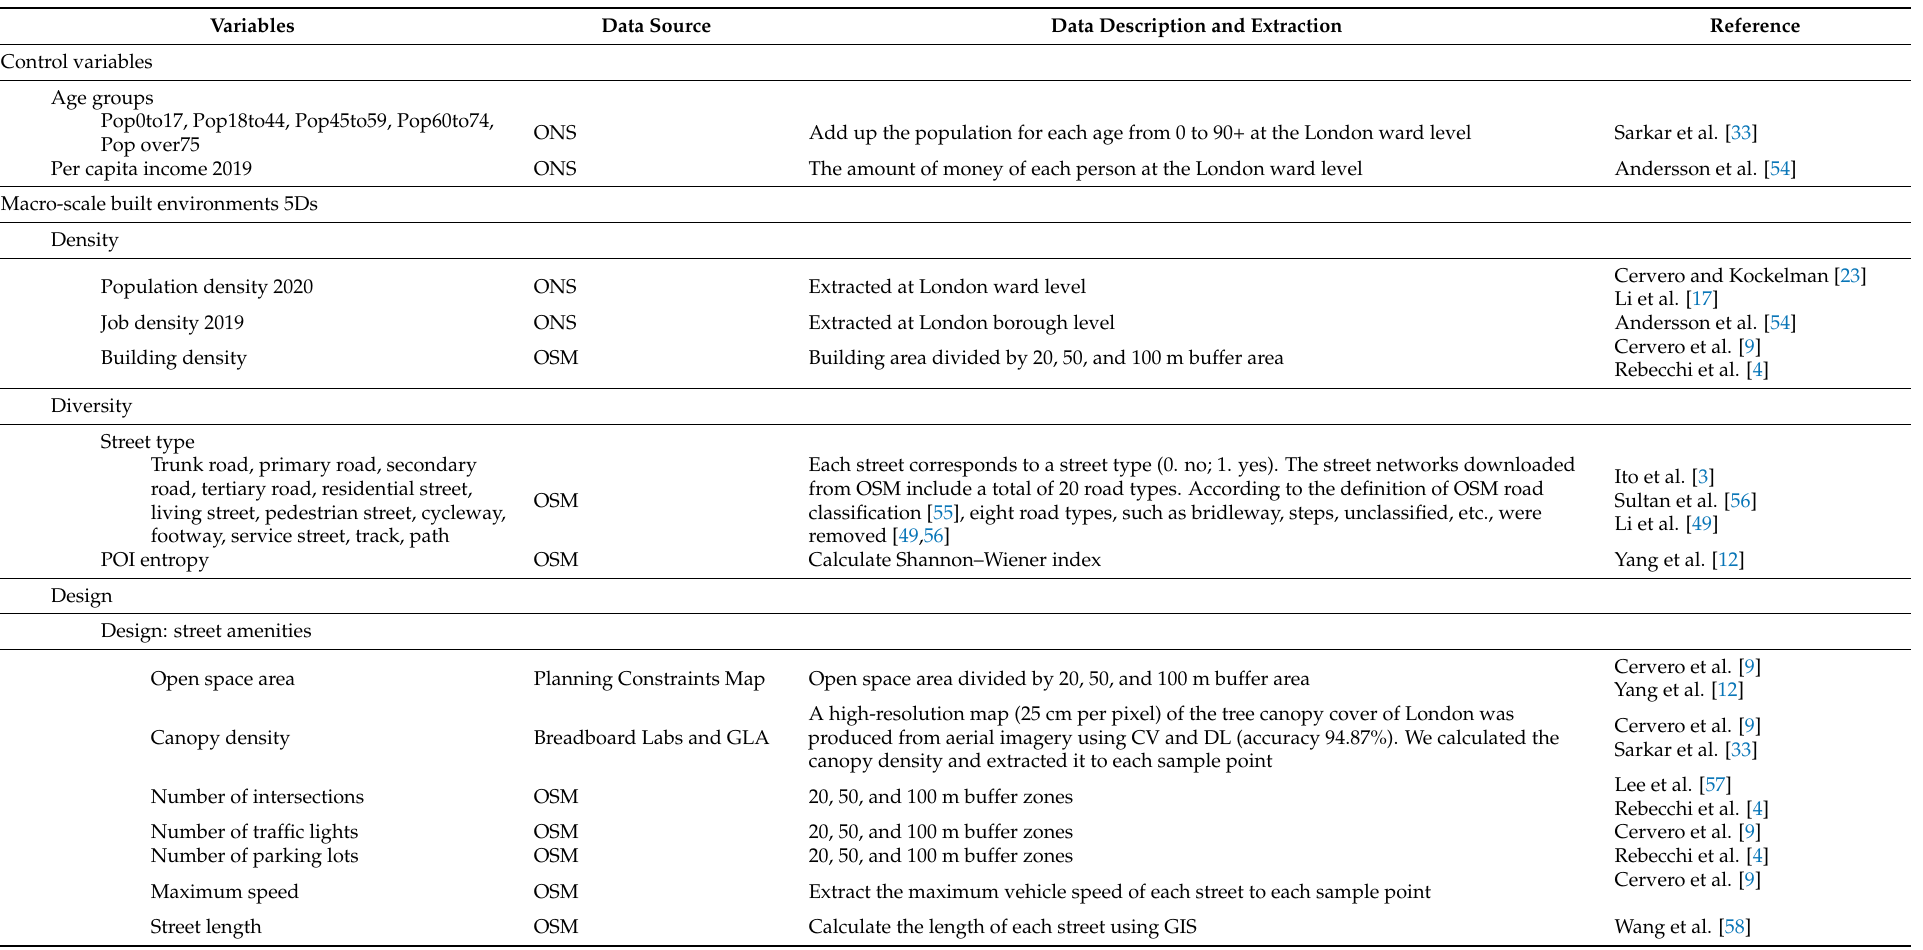
Table 1. The data sources and extraction methods of all independent